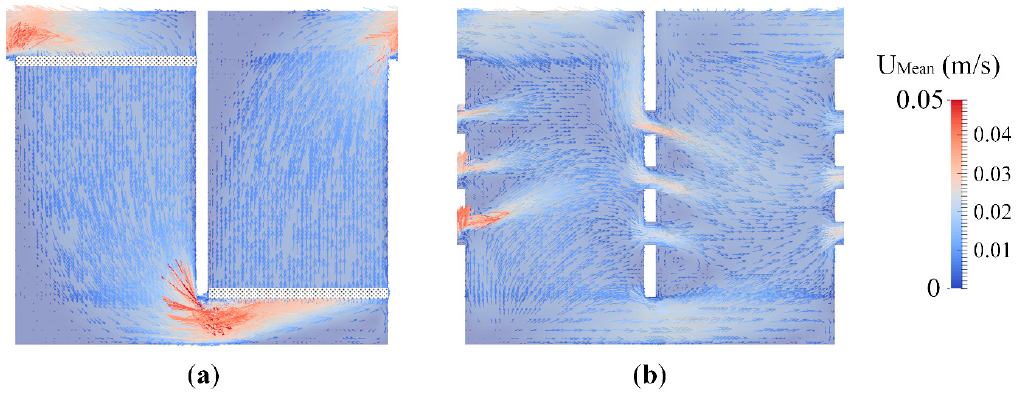
Figure 3. Comparison of the time-averaged flow fields in chambers two and three for the ( a ) Porous design 2 and ( b ) Slot-baffle design.